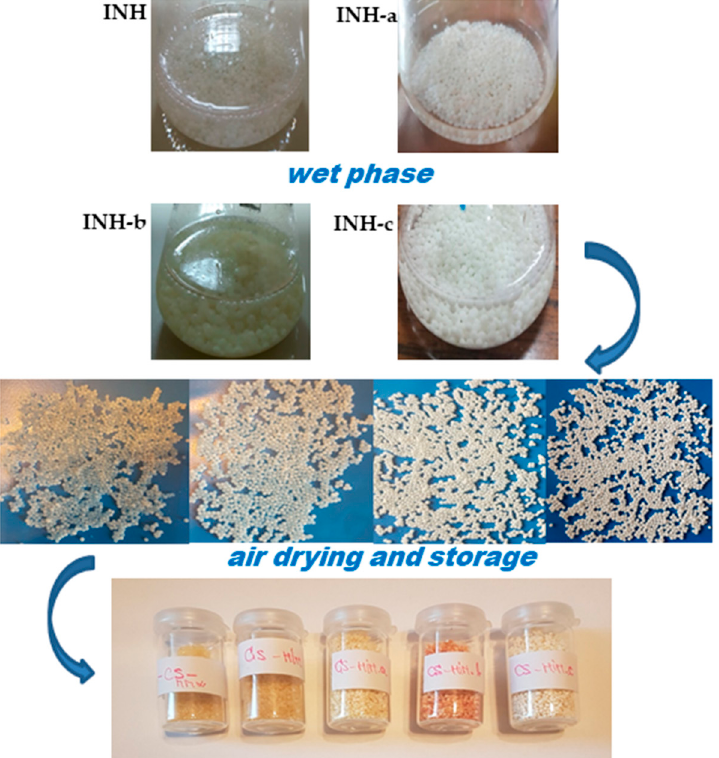
Figure 3. Obtaining chitosan microparticles containing isoniazid (INH) and its condensation products (INH-a, INH-b and INH-c): the wet phase and air drying. The morphological study showed that the (empty) chitosan microparticles had a regular contour, a spherical and slightly rough surface and a size of about 250 µm in the dry state, showing relative transparency (Figure 4).